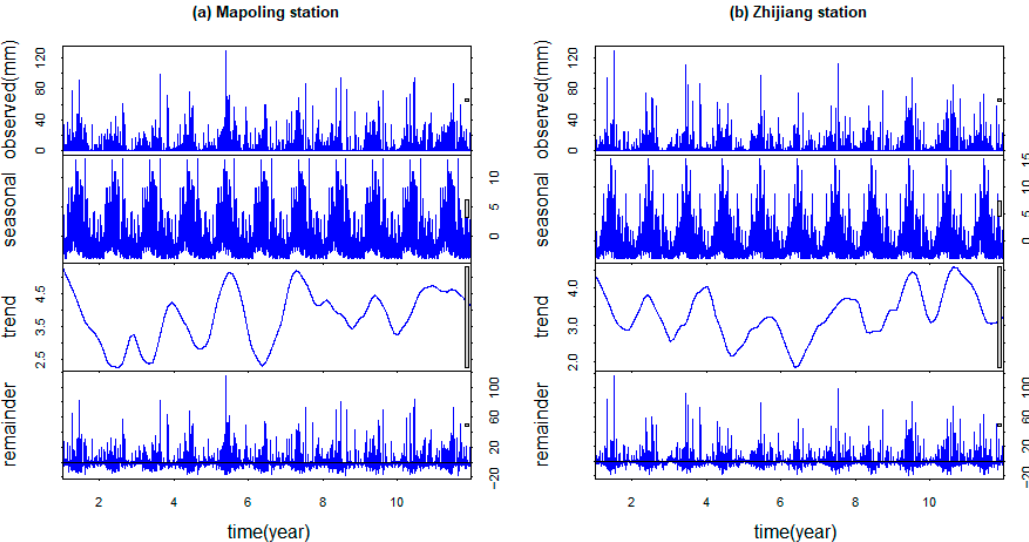
Figure 4. Decomposition of daily precipitation using the Seasonal and Trend decomposition using Loess (STL) method at ( a ) Mapoling station and ( b ) Zhijiang station. From top to bottom, the plot shows the original observed daily precipitation, seasonal, trend, and the remainder component,